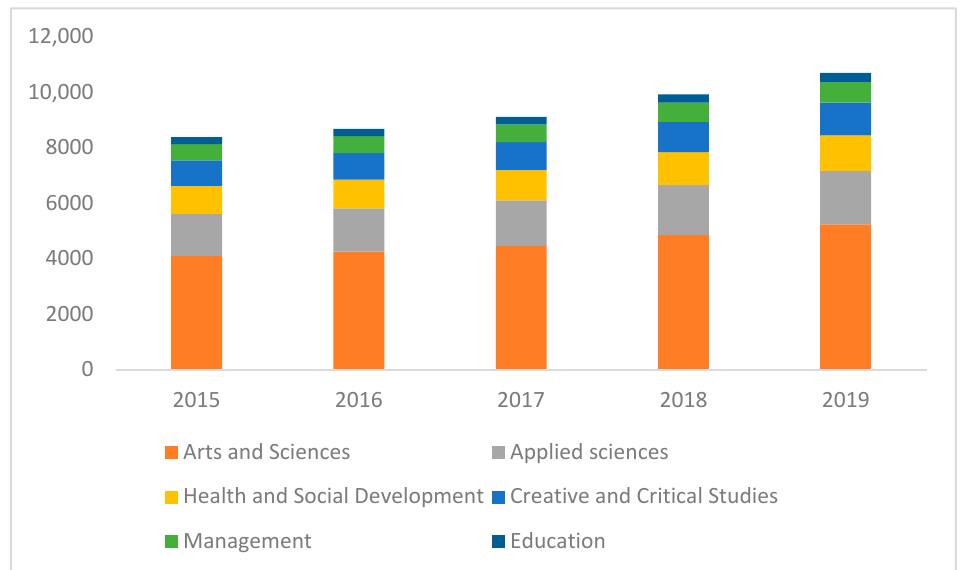
Figure A1. Student enrollment in the University of British Columbia Okanagan (UBCO) in the past five years.